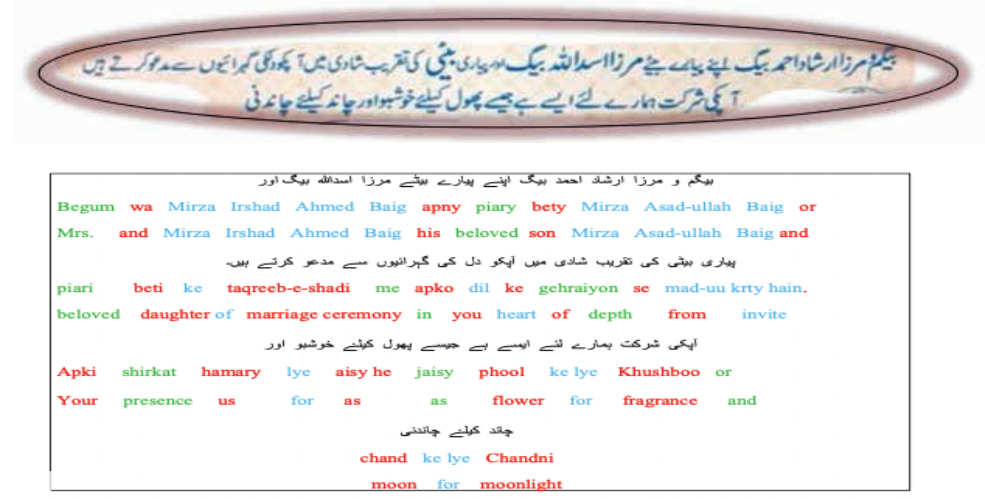
Figure 6: Requesting the presence in Urdu wedding